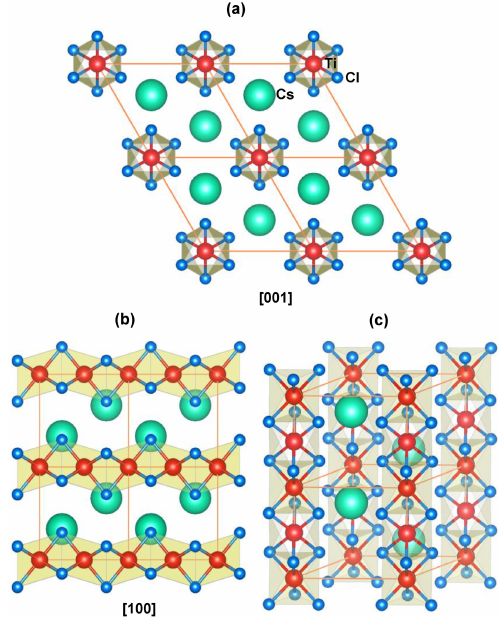
Figure 31: Structural models of CsTiCl 3 with 1-dimensional continu- ous perovskite structures, observed along (a) [001] and (b) [100]. (c) Perspective view of the structure.